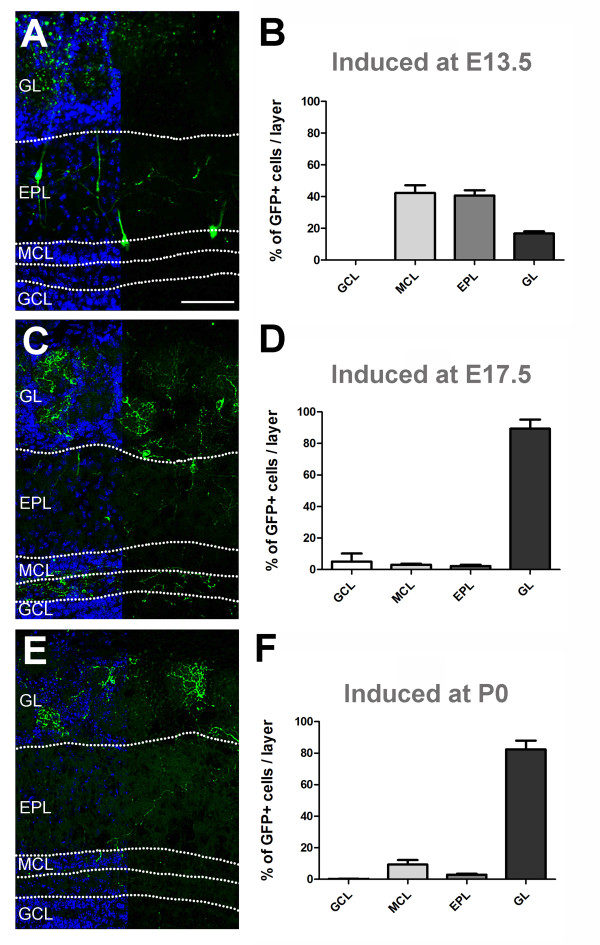
Neurog2 progeny populate distinct OB layers during embryonic development. (A,C,E) Overview of the distribution of GFP-positive cells in the OB of P21 Neurog2CreERT2 × TaukiGFP mice. The recombination was induced at E13.5 (A), E17.5 (C) and at birth (E) by a single injection of tamoxifen. DAPI counterstaining (blue) on the left side of the photomicrograph visualizes the distinct OB layers. (B,D,F) Quantification of the percentage of Neurog2-derived GFP-positive cells observed in the OB layers following tamoxifen injection at E13.5 (B), E17.5 (D) and at birth (F). Scale bar: 100 μm. EPL, external plexiform layer; GL, glomerular layer; GCL, granular cell layer; MCL, mitral cell layer. Error bars indicate S.E.M.